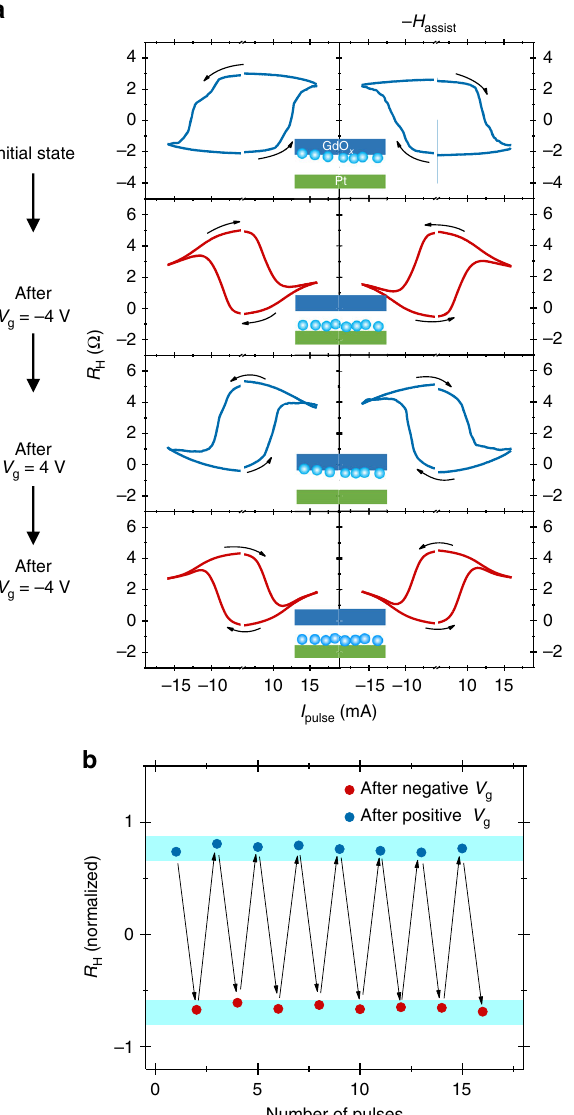
Fig. 5 Current-induced switching measurements. a The Hall resistance ( R H ) as a function of pulses current magnitude ( I pulse ) for a Pt (1.5nm)/Co (0.8nm) device after successive V g application at room temperature. The switching loops in a are shown for the assist fi eld ( H assist ) direction along ( + H assist ) and opposite ( − H assist ) to the current fl ow direction. b Repeated toggling of the R H by a unidirectional current after modulating the state of device with positive and negative V g . The switching measurements for the reversed device in a , b were performed at 150K at which the device regained